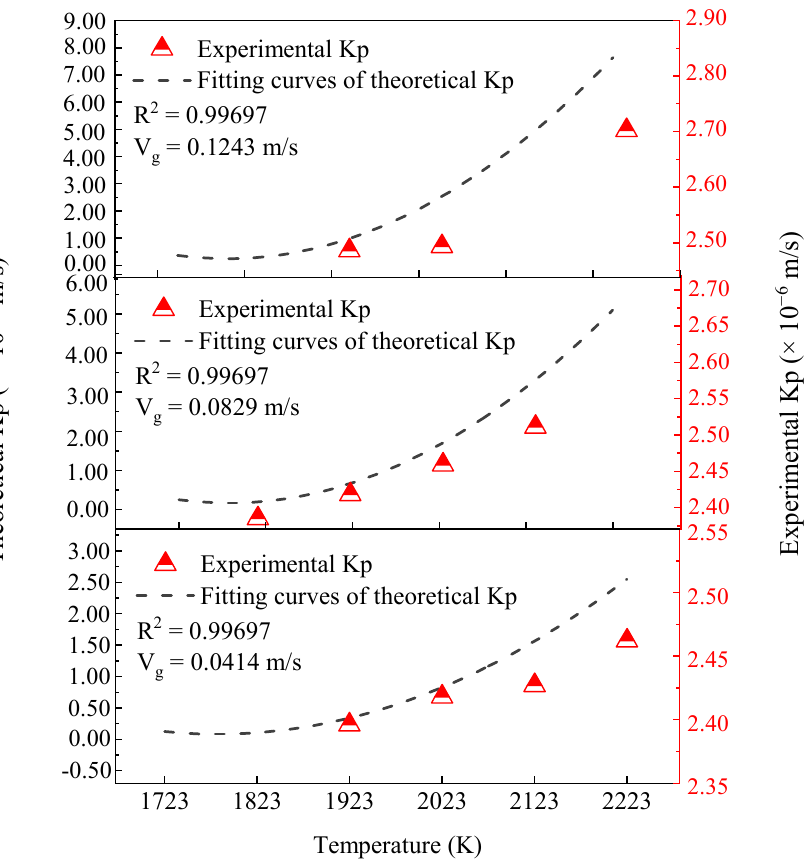
Figure 6. Effect of temperature on mass transfer coefficients.